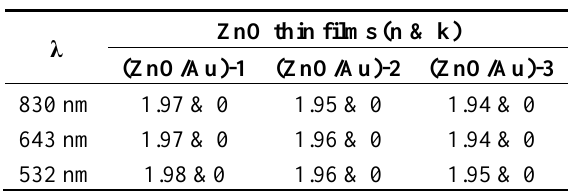
Table 2. Comparison between refractive indices of (ZnO/Au)-1, (ZnO/Au)-2, and (ZnO/Au)-3 devices measured at wavelengths of 830, 643, and 532 nm, respectively, measured at room